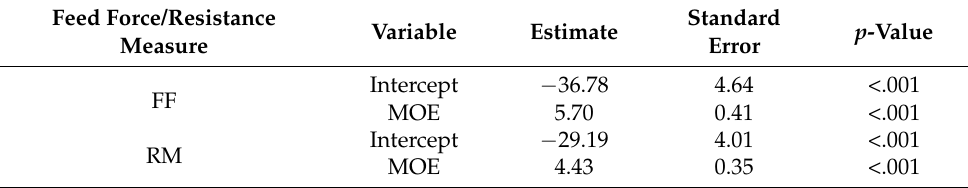
Table 14. Estimates for regression models of FF and RM with MOE as the predictor.